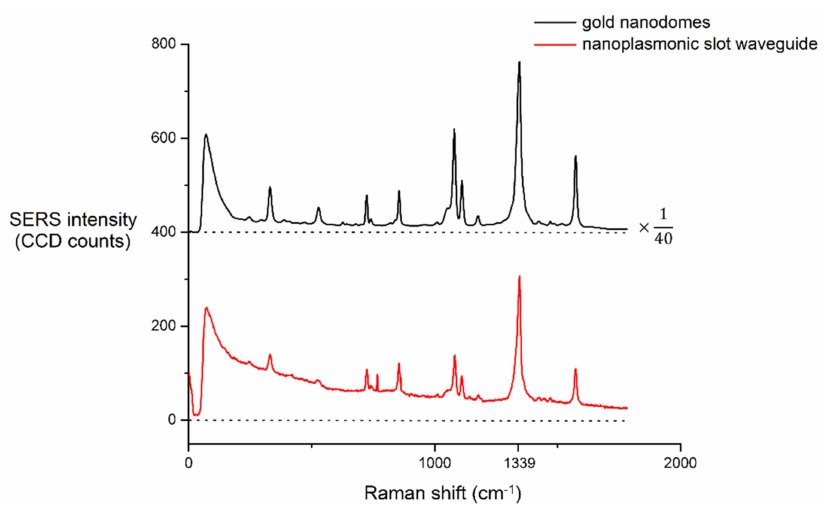
Figure 6. Averaged SERS spectra of the NTP monolayer acquired on gold nanodomes and on the nanoplasmonic slot waveguide. The spectrum on the gold nanodomes was obtained using a laser power of 300 µ W and an integration time of 0.13 s. The spectrum on the nanoplasmonic slot waveguide was obtained using a laser power of 350 µ W and an integration time of 10 s. The SERS spectrum on the nanodomes was divided by a factor of 40 to allow for better visualization. We subtracted the dark counts, but not the SERS background of the spectra. The spectra are o ff set on the y-axis for clarity, and the dashed line represents the zero line of each